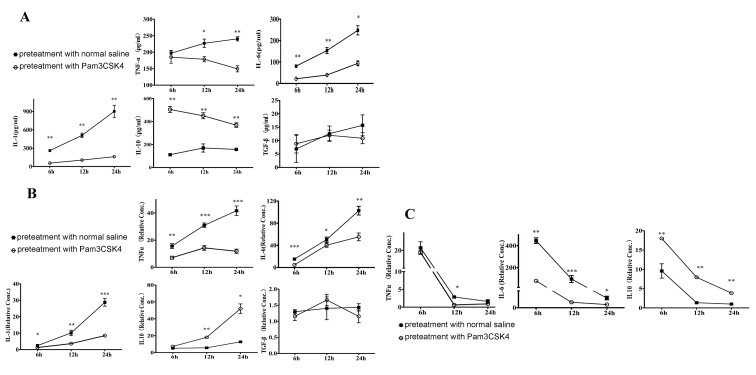
Pretreatment with Pam3CSK4 decreases inflammatory cytokine production.Lung tissues were collected and homogenized at 6, 12 and 24 h after MRSA infection. Organ extracts were centrifuged and supernatants were collected. Cytokine concentrations were measured by ELISA kits for TNF-α, IL-6, IL-1β, IL-10 and TGF-β according to the manufacturer’s instructions (A). Kinetics of cytokine mRNA levels of TNF-a, IL-6, IL-1β, IL-10 and TGF-β were tested in mouse lung at indicated times by qPCR (B). The mRNA levels of TNF-a, IL-6 and IL-10 in mouse bronchus were detected using qPCR (C). These data are representative of three independent experiments in duplicate wells (each group, n = 3–5), and the results are shown as means ± SEM. Note: *P<0.05; **P<0.01; ***P<0.001 versus normal saline-treated mice.